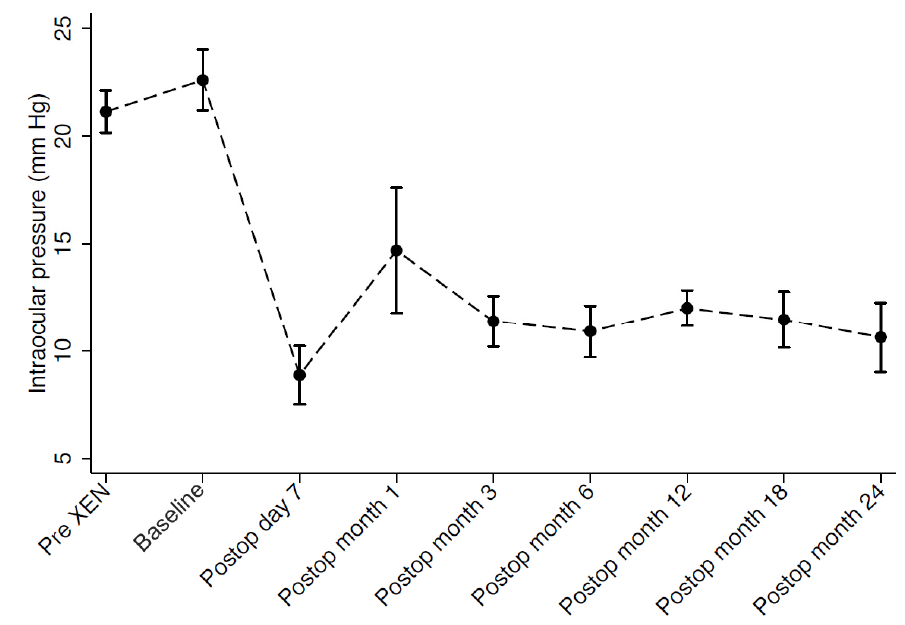
Figure 1. Graph showing mean intraocular pressure through 24 months of follow-up.